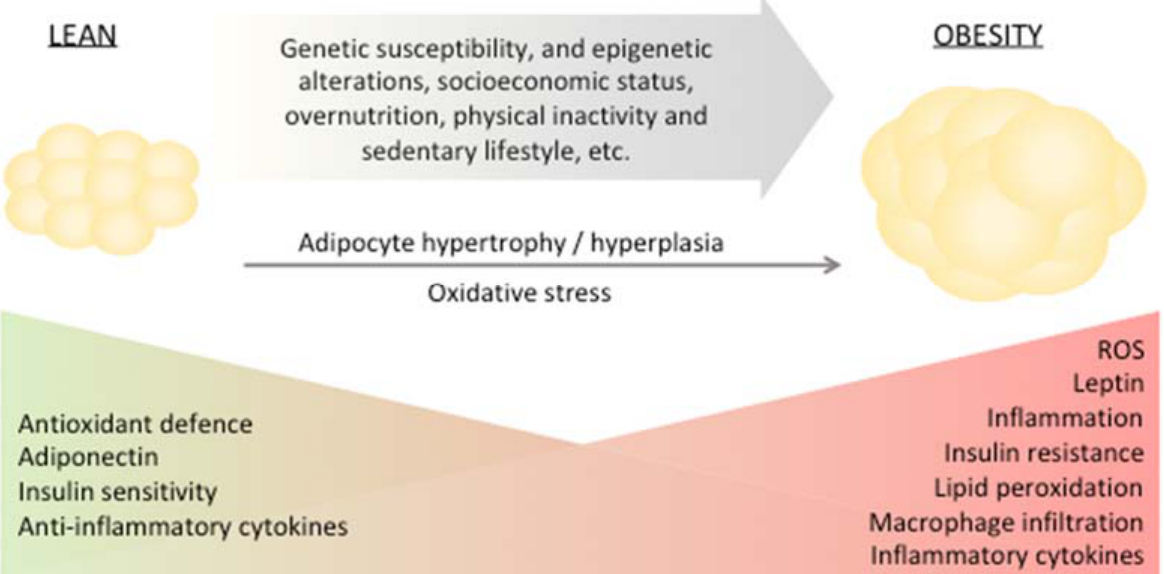
Figure 1. Genetic susceptibility and epigenetic alterations, socioeconomic status, overnutrition, physical inactivity and sedentary lifestyle are among the main factors driving the development of obesity. Obesity is marked by altered redox homeostasis in favor of prooxidants, inflammation, el ‐ evated adipose tissue macrophage infiltration and leptin secretion and decreased antioxidant re ‐ sponse, insulin sensitivity and adiponectin. Eventually, these events result in oxidative stress and generation of lipid peroxidation ‐ derived aldehydes promoting insulin resistance.